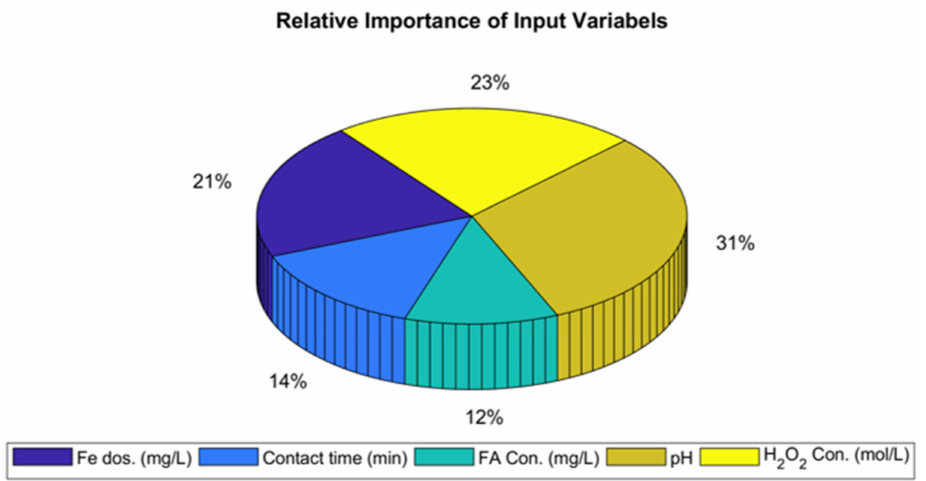
Figure 5. Importance percentages of the independent factors (Fe dosage, contact time, formalde- hyde concentration, pH and H 2 O 2 concentration) affecting the formaldehyde removal during the Fenton